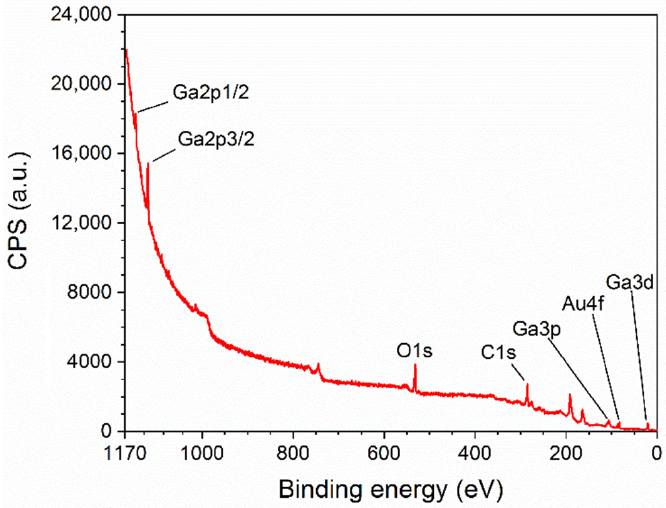
Figure 6. The chemical composition of β -Ga 2 O 3 nanowire.